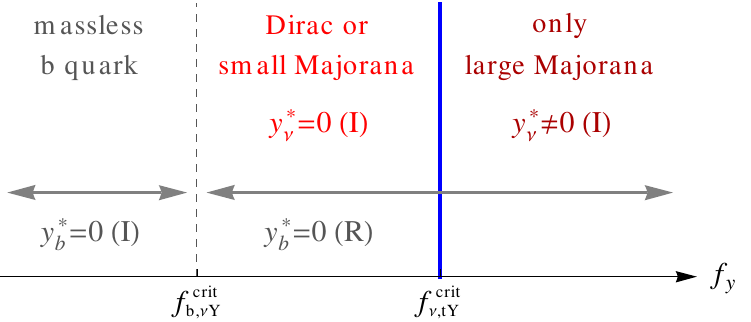
Figure 4. Implications for the low-energy particle spectrum as a function of the gravitational parameter f . In the region f , where f crit crit ≈ 8 . 2 × 10 − 4 in the SM plus right-handed y y > f ν,tY ν,tY neutrinos, fixed-point value y ∗ (irrelevant) is of order one. One requires a large Majorana mass in ν the Lagrangian to suppress the SM neutrino mass. In the region f crit one gets y ∗ = 0 < f y < f crit ν ν,tY b,νY along an irrelevant direction of the flow: neutrinos of the Dirac type can naturally get their mass via the Higgs mechanism, or one might introduce light sterile neutrinos. In the region f , crit y < f b,νY where the value f crit depends on the selected phase-space trajectory (see main text), the bottom b,νY Yukawa coupling features a Gaussian fixed point along an irrelevant direction of the flow, which leads to the prediction of a massless bottom